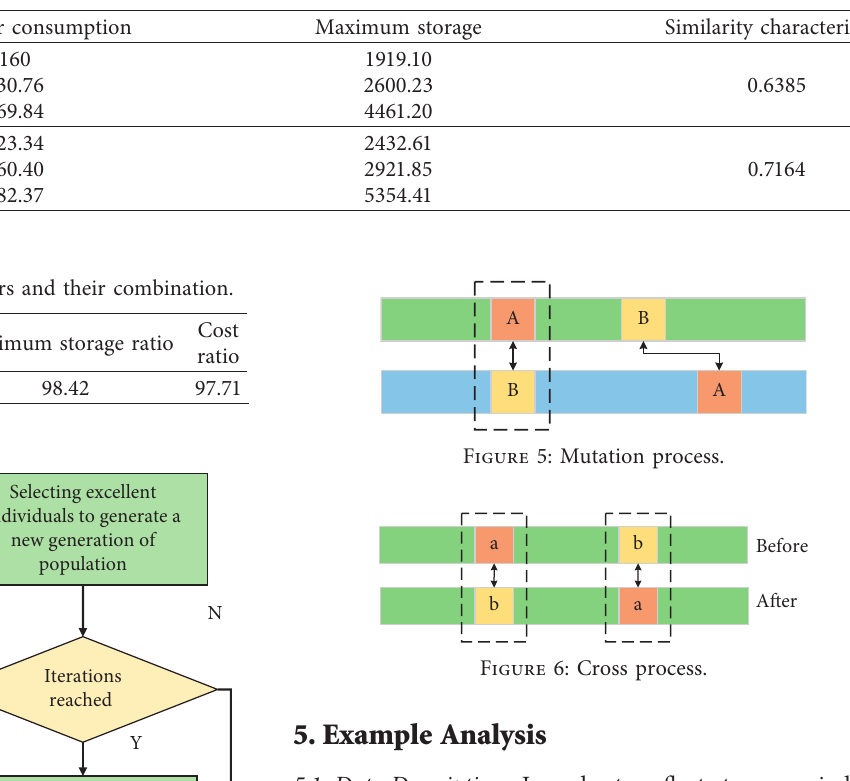
Table 4: Statistic of users and their combination.